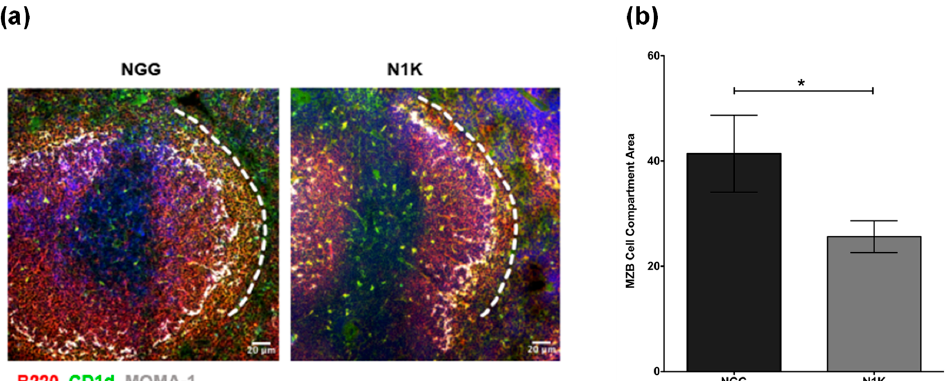
Figure 6. Topically administered TSP1-derived peptides decrease the area of splenic MZB cells in immunized TSP1 − / − mice. ( a ) Representative images of frozen sections of spleen from N1K- and NGG- treated TSP1 − / − mice (100×; scale bar, 20 µm). Sections were immunostained for MZB cells (B220 + CD1d + )-B220 (red), CD1d (green), MOMA-1 (grey white), and nuclear stain DAPI (blue). The MOMA-1 + (grey white) macrophages around follicles and the white dotted line mark the inner and outer boundaries of the MZB cell compartment, respectively. ( b ) Quantitative assessment of area covered by MZB cells determined using the ImageJ software as described in Section 4.4. Five to six images representing independent areas and animals per experimental group were analyzed; Data represents Mean +/ − SEM; * p < 0.05.